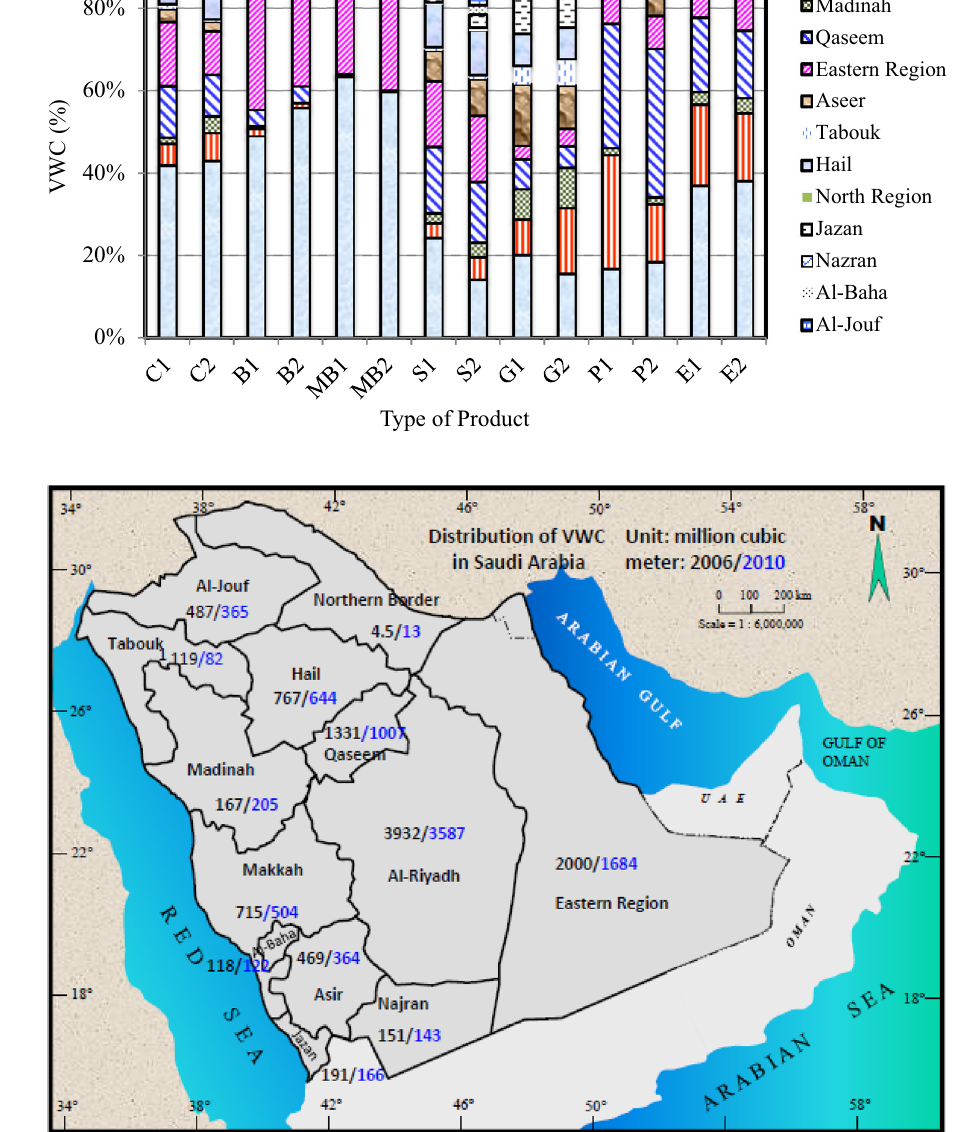
Fig. 3 Percentile distributions of product specific regional VWC in 2006 and 2010. C camel, B cow (only for meat production), MB dairy cow, S sheep, G goat, P poultry, E egg; subscripts 1 and 2 represents 2006 and 2010